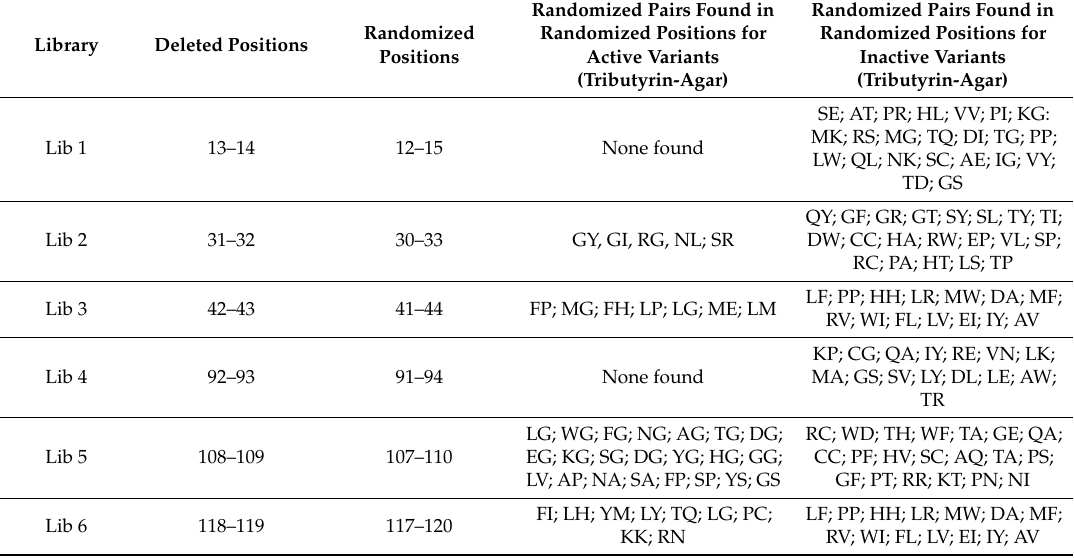
Table 2. Identified amino acid substitutions for active and inactive enzyme variants for each deletion / randomization library of